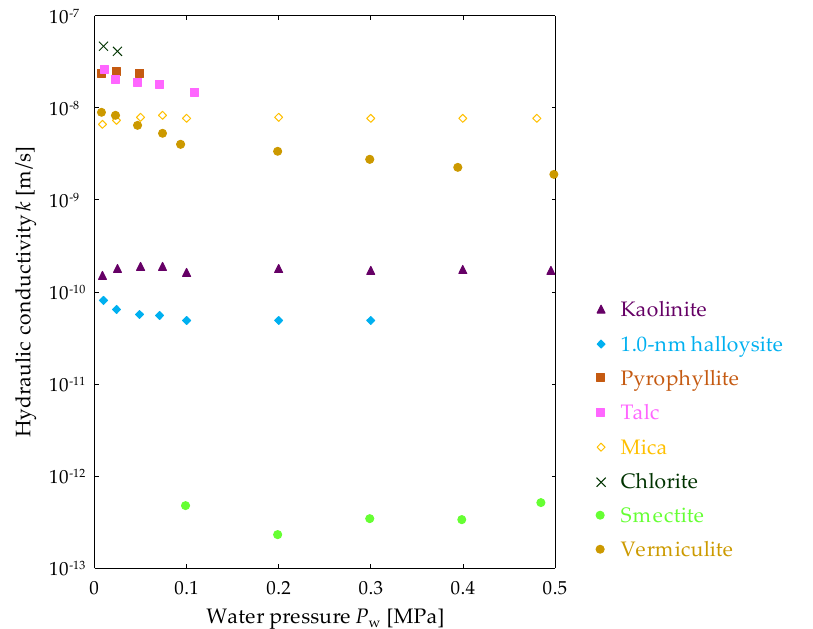
Figure 9. Relationship between water pressure and hydraulic conductivity of clay mineral samples (void ratio = 0.95).